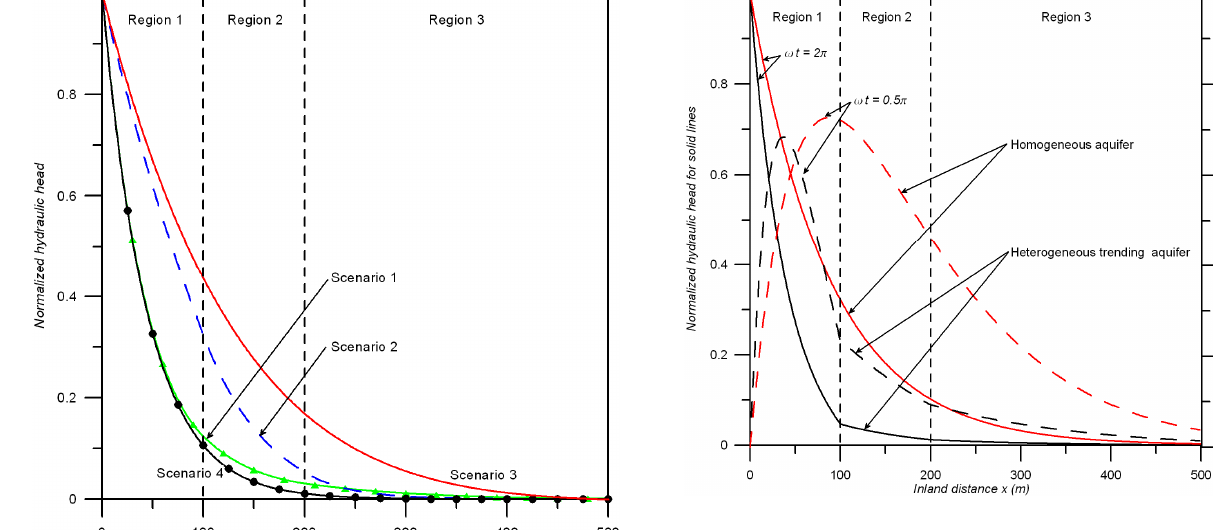
Figure 7. The spatial head distributions for the homogeneous aquifer and heterogeneous trending aquifer at ωt = 2 π and ωt = 0 . 5 π